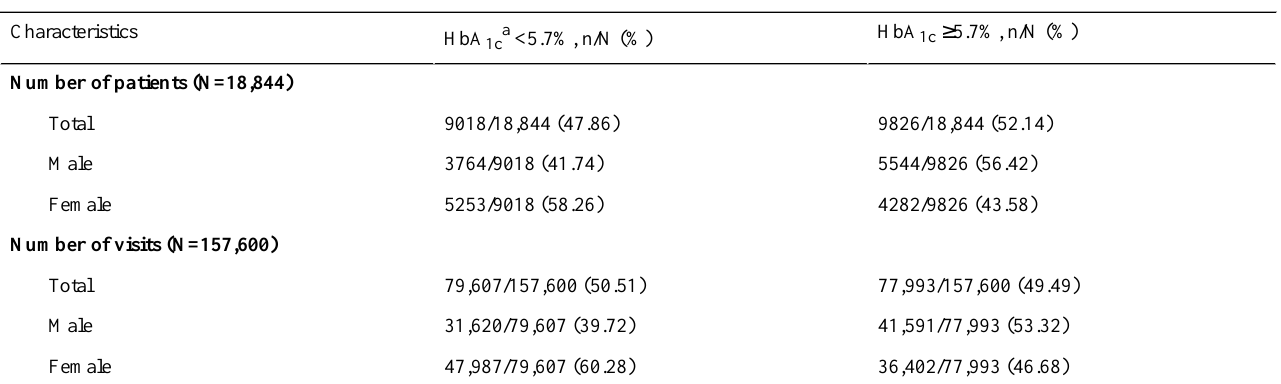
Table 1. Profile for the class distribution over